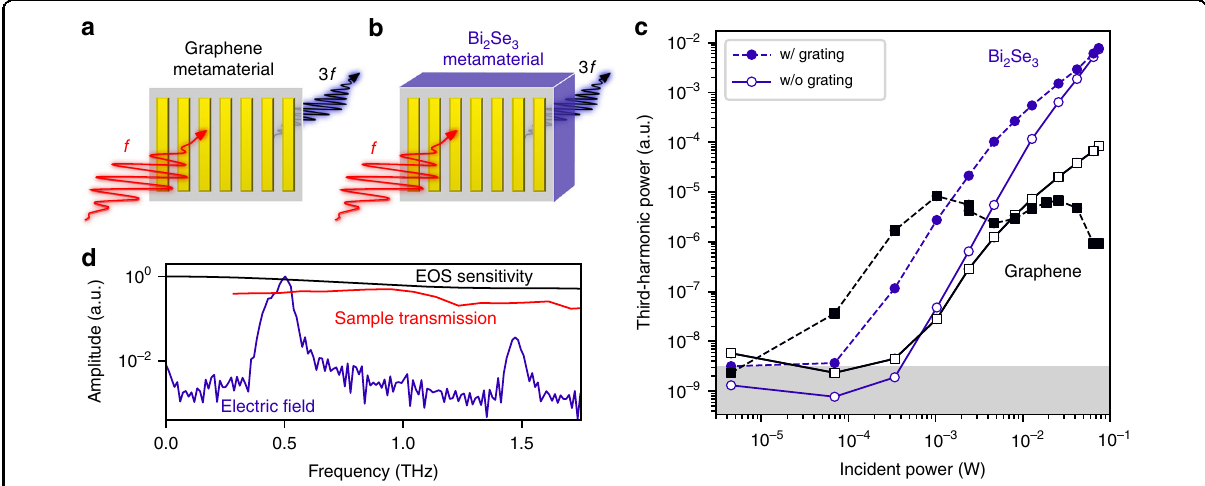
Fig. 1 THz harmonic generation in Bi 2 Se 3 vs. graphene. a , b Schematic experimental layout of third-harmonic generation studies in graphene ( a ) and Bi 2 Se 3 ( b ) metamaterials. c The THz third-harmonic power is enhanced by the metallic gratings for both graphene (black squares and lines) and Bi 2 Se 3 (blue circles and lines). However, the power saturates strongly for graphene, and therefore eventually Bi 2 Se 3 outcompetes graphene by around two orders of magnitude. The largest pump intensity corresponds to an incident peak fi eld strength of 300 kV cm – 1 . d Transmitted spectral amplitude (normalized) after the Bi 2 Se 3 metamaterial sample (blue line), with a 3 f signal that is ~4% of the fundamental signal at f . Both the sample transmission (red line) and electrooptic sampling (EOS) sensitivity of the 2 mm thick ZnTe detection crystal (black line) are lower at 3 f than at f . Taking into account the lower EOS sensitivity, the fi eld-conversion ef fi ciency is 8%, corresponding to 0.5 mW of generated harmonic